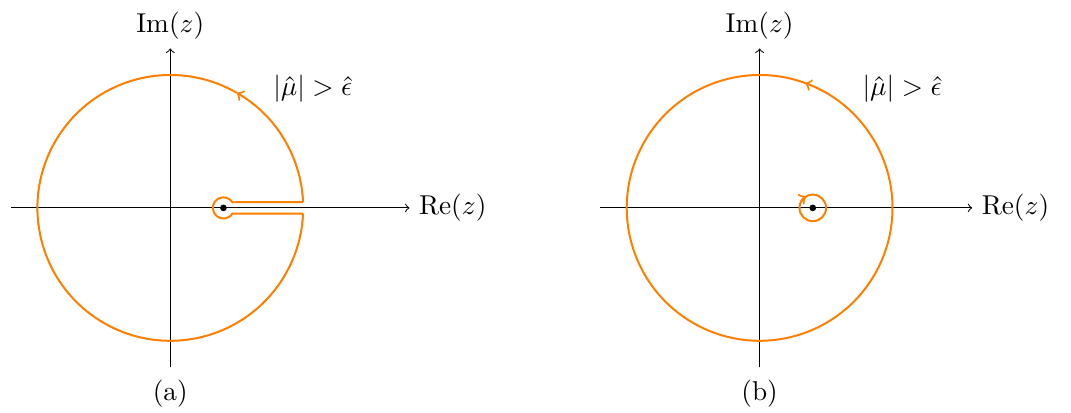
Figure 11 . Bosons: the pole is at z = + e β ( (cid:15) − qµ ) and is denoted by the black dot on the +ve real axis. Radius of the big circle is unity. The orange curve is the contour C 0 (counterclockwise) over which the holonomy is integrated